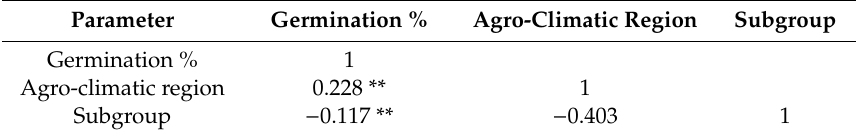
Table 3. Correlations between percentage germination, regions and population